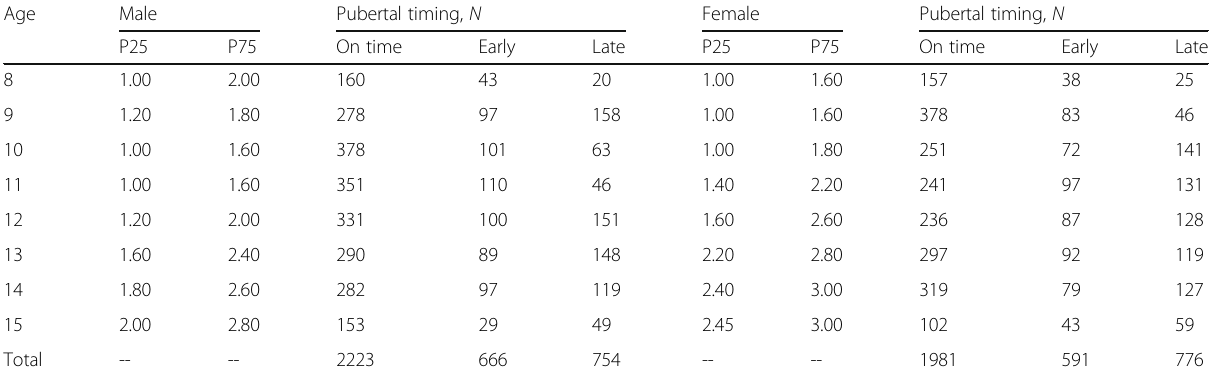
Table 1 The scores of important puberty timing events in adolescents aged 8 – 15 in QiJiang District, Chongqing Age Male Pubertal timing, N Female